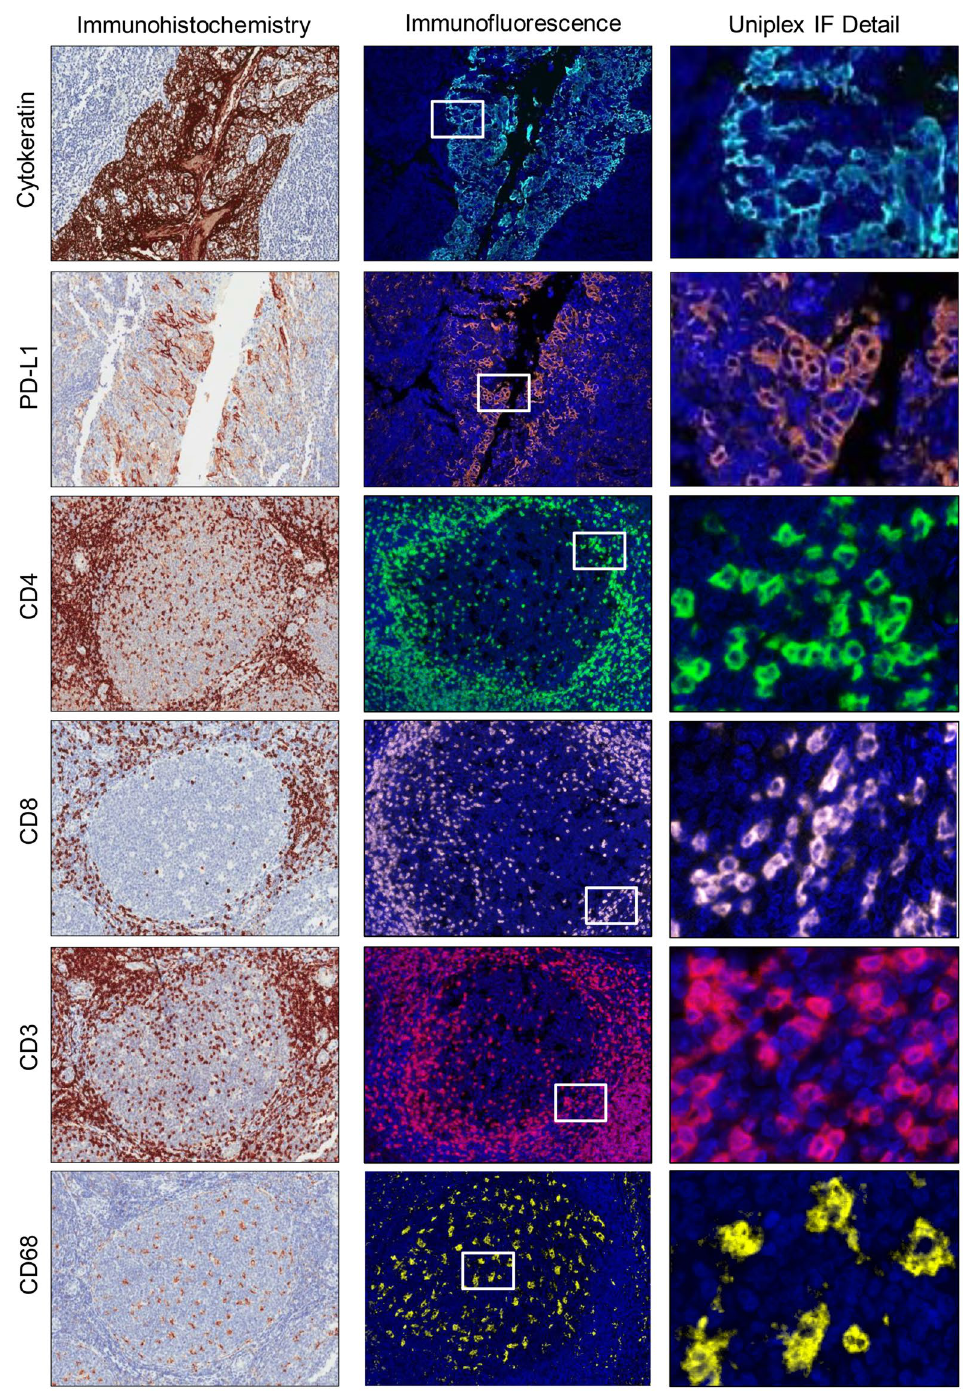
Figure 1. Microphotographs of representative examples of validation from IHC ( left panels ), uniplex IF tumor- associated immune cell expression ( middle panels ), and details of uniplex IF in tonsil tissue ( right panels ). Immune panel 1: AE1/AE3 (cytokeratin-positive), PD-L1–positive, helper T cell (CD4-positive), cytotoxic T cell (CD8-positive), T-cell lymphocyte (CD3-positive), and macrophages (CD68-positive). × 200 magnification and high-power magnification of the positive